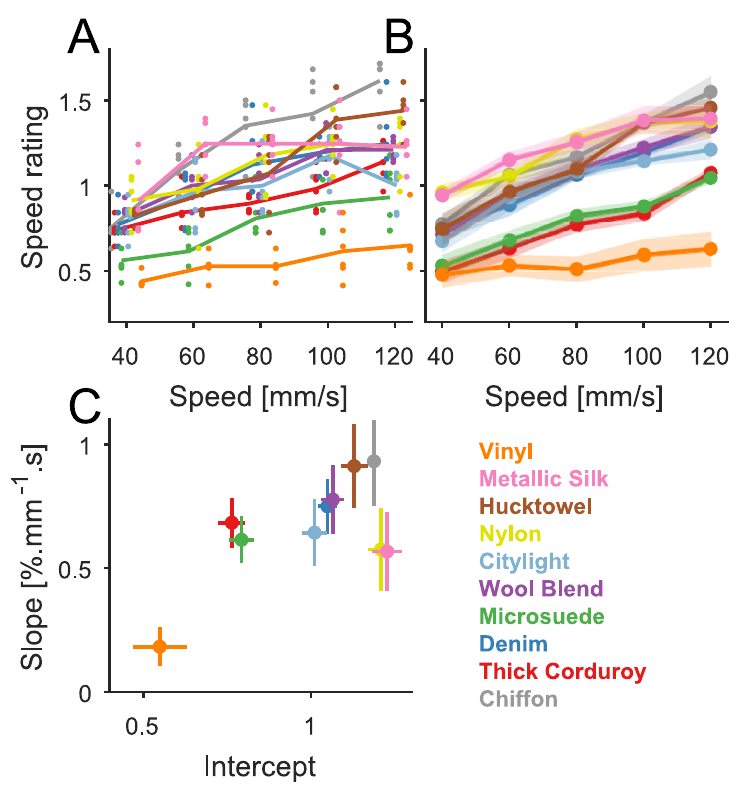
Fig 1. Speed ratings across textures. (A) Magnitude estimates of speed obtained from an example subject. Normalized speed ratings for different textures are shown in different colors. Dots denote single trials ( n = 6 per condition), and lines denote means. (B) Average speed rating for all subjects ( n = 10). Dots denote the mean, and shaded areas denote the SEM. (C) Coefficients (slope versus intercept) of the linear regression relating speed ratings to speed. Error bars denote the SEM ( n = 10). Data underlying this figure can be found in S1